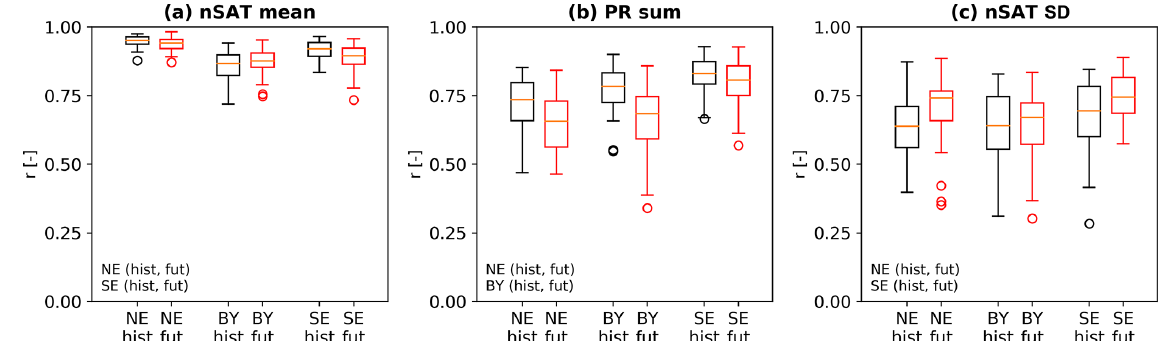
Figure 11. Temporal covariability of CanESM2-LE and CRCM5-LE subset regions in all 50 members. Each boxplot represents 50 Pear- son correlation coefficients of the time series of variables nSAT mean (a) , PR sum (b) and nSAT SD (c) in the subset regions between CanESM2-LE members and the corresponding CRCM5-LE members. Time periods used for correlations are 1981–2010 (hist, black) and 2070–2099 (fut, red). Text denotes combinations of which the differences are significant at p ≤ 0 . 05 using an unpaired Mann–Whitney/ U test. Orange line in boxplots is the median. For regions NE, BY and SE, see Fig.